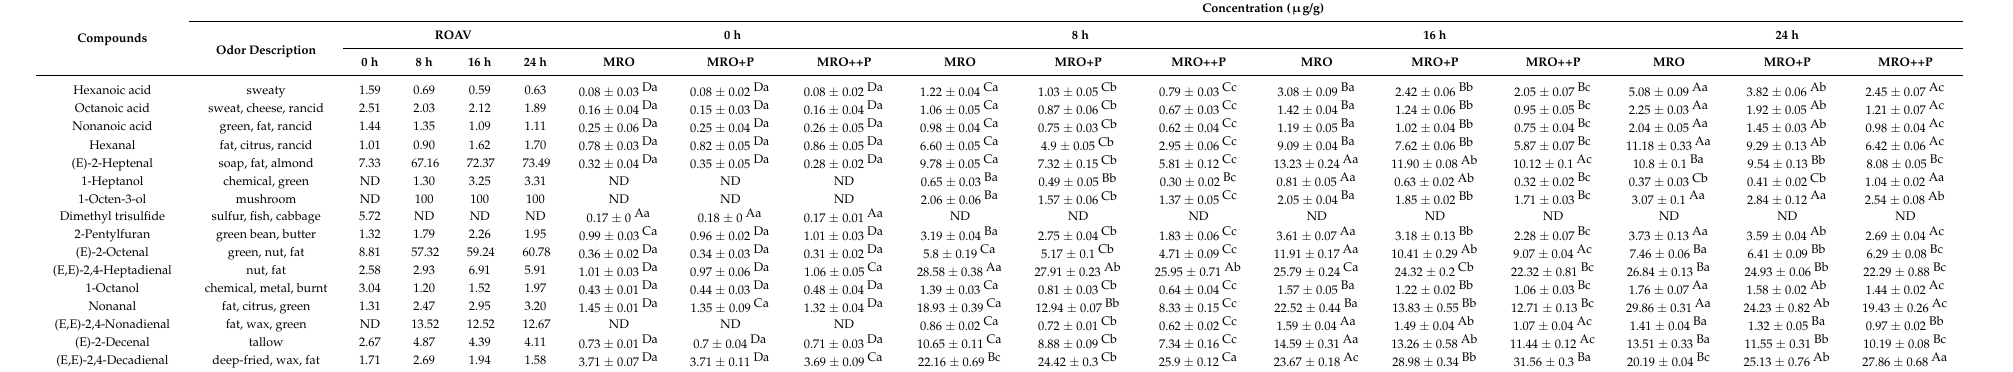
Table 4. Effects of HCP on concentrations of characteristic flavor compounds during